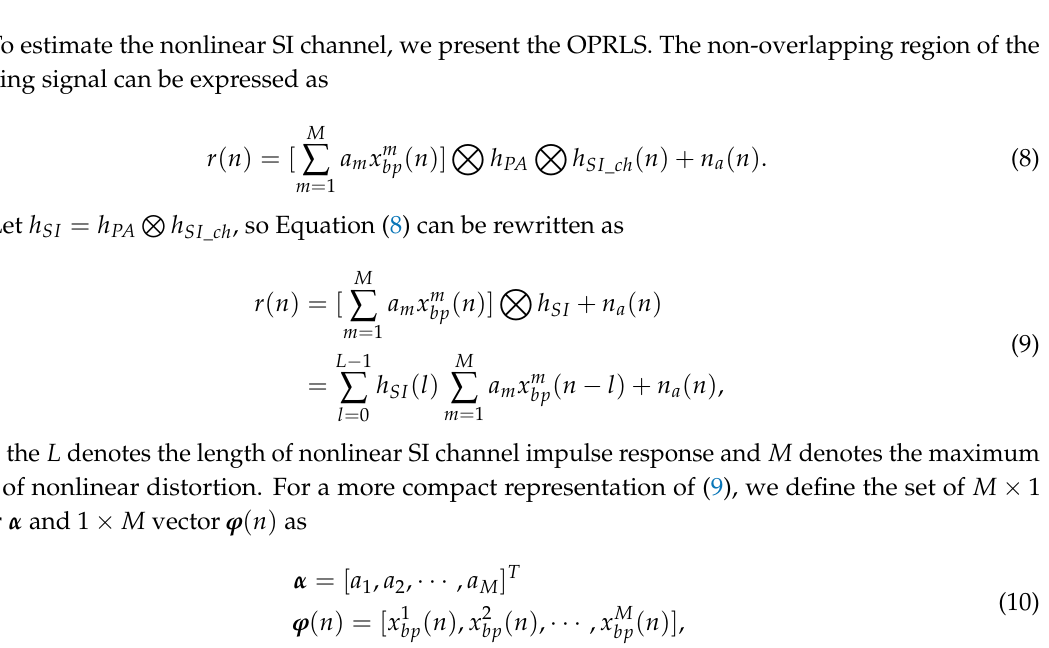
Figure 3. Processing flow chart of digital SI